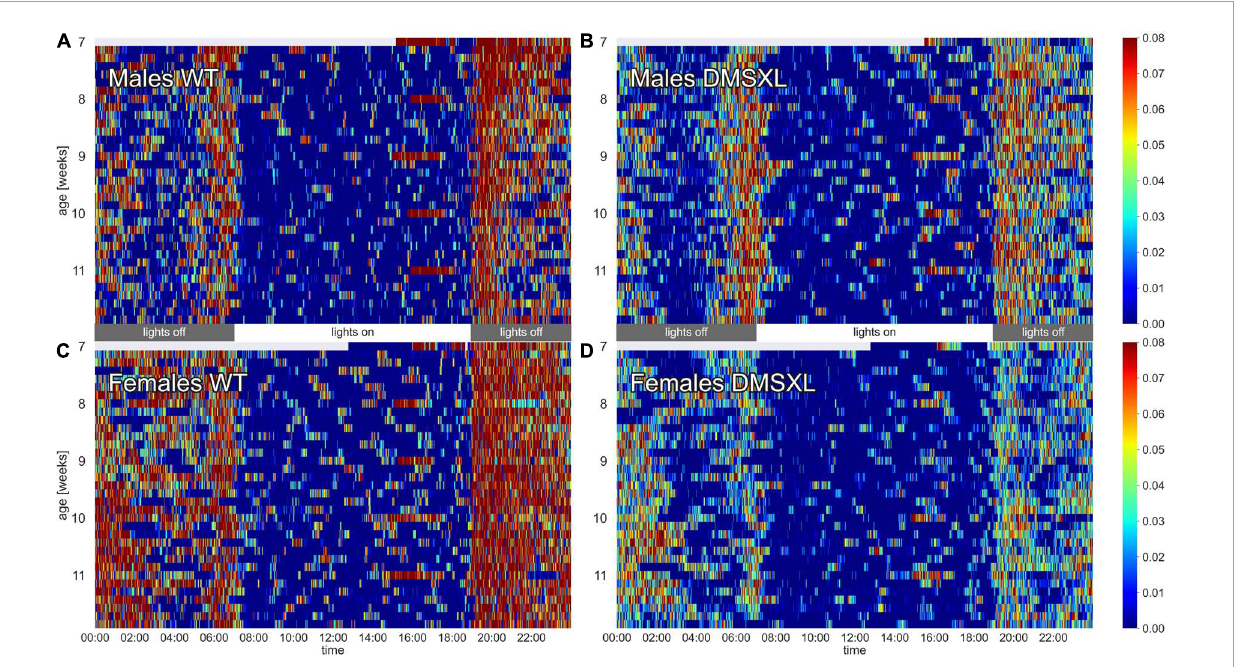
FIGURE1 Heatmaps of activity. The figure depicts average minute activity across 24 h and over 5 weeks in four representative cages of wild-type (WT) male (A) , DMSXL male (B) , WT female (C) , and DMSXL female (D) mice ( n = 2 per cage). Lights-on is from 7 a.m. to 7 p.m.